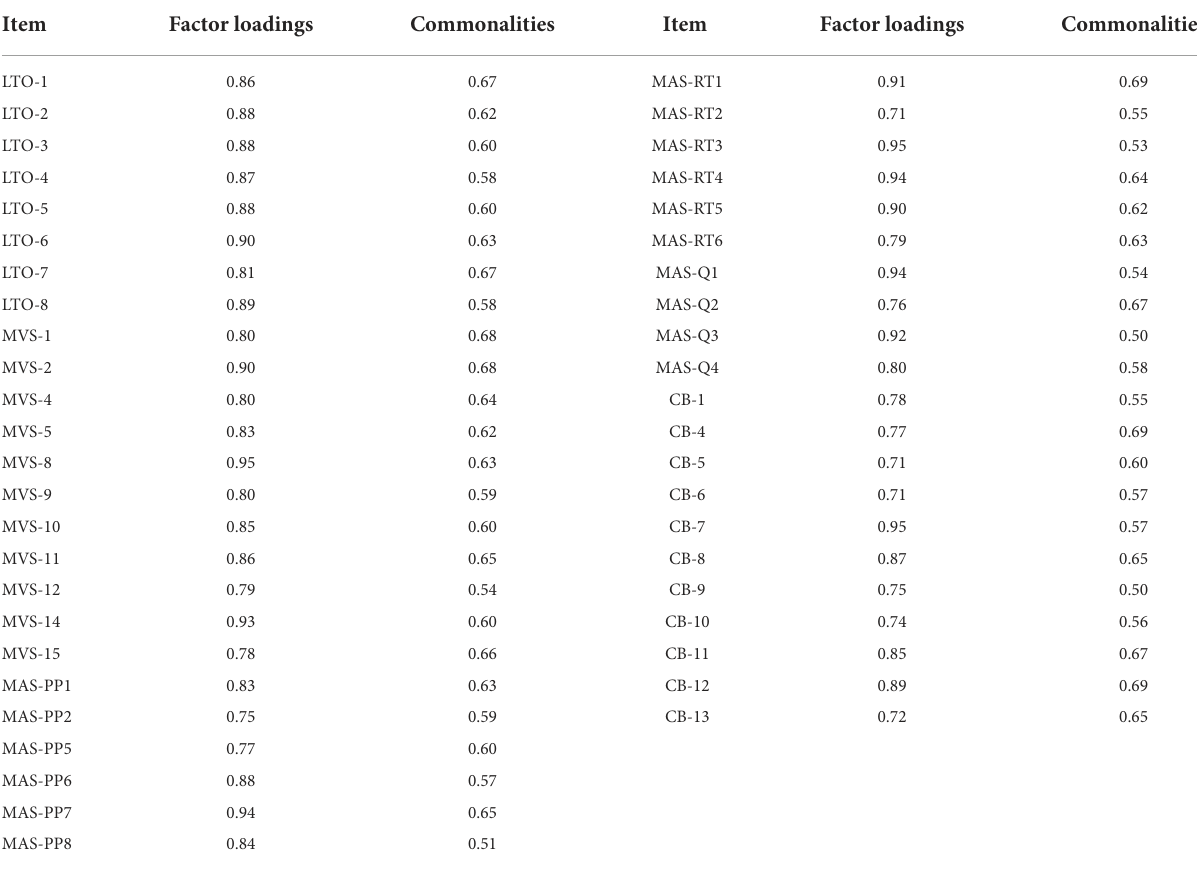
TABLE 2 Survey items and their loadings and commonalities.